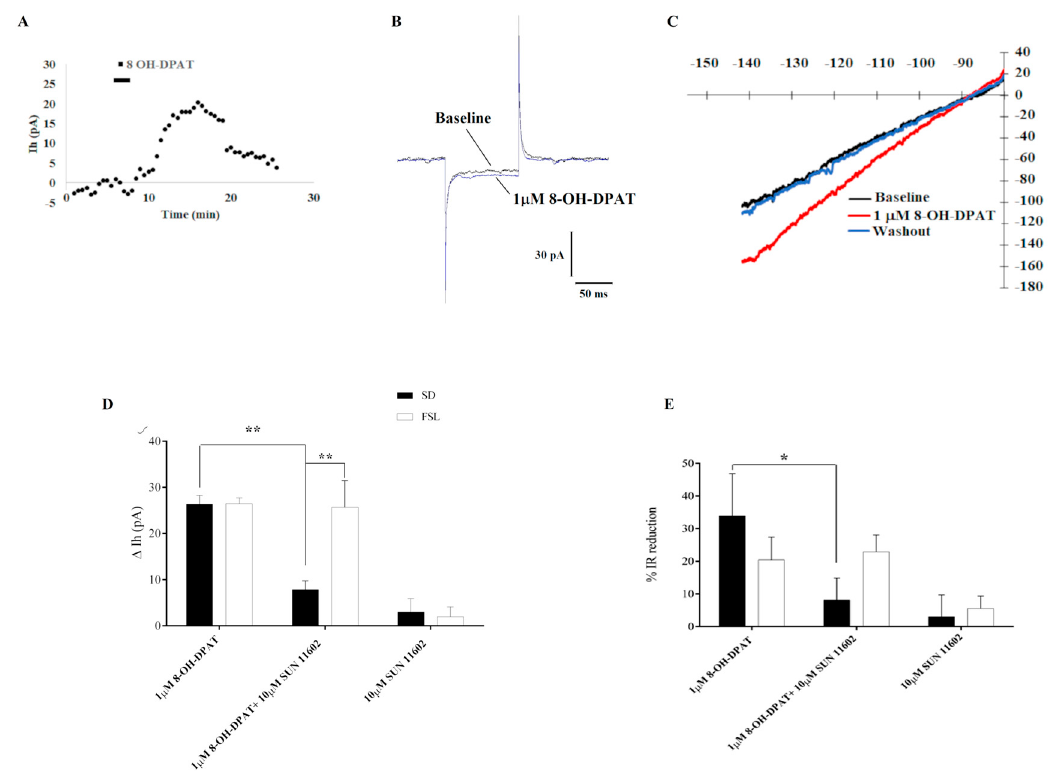
Figure 4. 8-OH-DPAT-activated inwardly rectifying K + conductance in dorsal raphe nucleus (DRN) serotonergic neurons. ( A ) Time-course of a representative experiment showing the effect on holding current (Ih) at − 70 mV of 5HT1A receptor agonist 8-OH-DPAT bath application mediated by inwardly rectifying K + conductance. ( B ) 8-OH-DPAT application induces an input resistance (IR) decrease, suggesting a membrane channel opening. ( C ) Representative current-voltage (Im-Vm) correlation plot. Traces are recorded before (Baseline; black line), during agonist application (1 µ M 8-OH-DPAT; red line), and after washout (Washout; blue line). ( D ) Whole-cell patch-clamp analysis of DNR neurons showed that the activation of 5HT1AR induced an outward Gi/o-mediated current in DRN serotonergic neurons due to GIRK channel opening. Two-minutes-long combined application of 1 µ M 8-OH-DPAT together with 10 µ M SUN 11602 significantly reduced the amplitude of the 5HT1AR-induced GIRK current at − 120 mV in SD but not in FSL rats. Two-way analysis of variance (ANOVA) F (2, 31) = 26.82, p < 0.0001; Tukey’s post hoc: ** p < 0.01. Number of recorded cells (n) SD: 8-OH-DPAT (5), 8-OH-DPAT + SUN 11602 (7), SUN 11602 (4); FSL: 8-OH-DPAT (7), 8-OH-DPAT + SUN 11602 (7), SUN 11602 (7); ( E ) GIRK channel opening decreased IR of DRN neurons. Combined agonist treatment tended to reduce the IR drop elicited by 5HT1AR-induced GIRK activation in SD rats but not in FSL. Two-way analysis of variance (ANOVA) F (2, 32) = 5.213, p = 0.0110; Tukey’s post hoc: * p < 0.05. Number of recorded cells (n) SD: 8-OH-DPAT (5), 8-OH-DPAT + SUN 11602 (7), SUN 11602 (4); FSL: 8-OH-DPAT (6), 8-OH-DPAT + SUN 11602 (8), SUN 11602 (8). All data are expressed as Mean ± SEM.